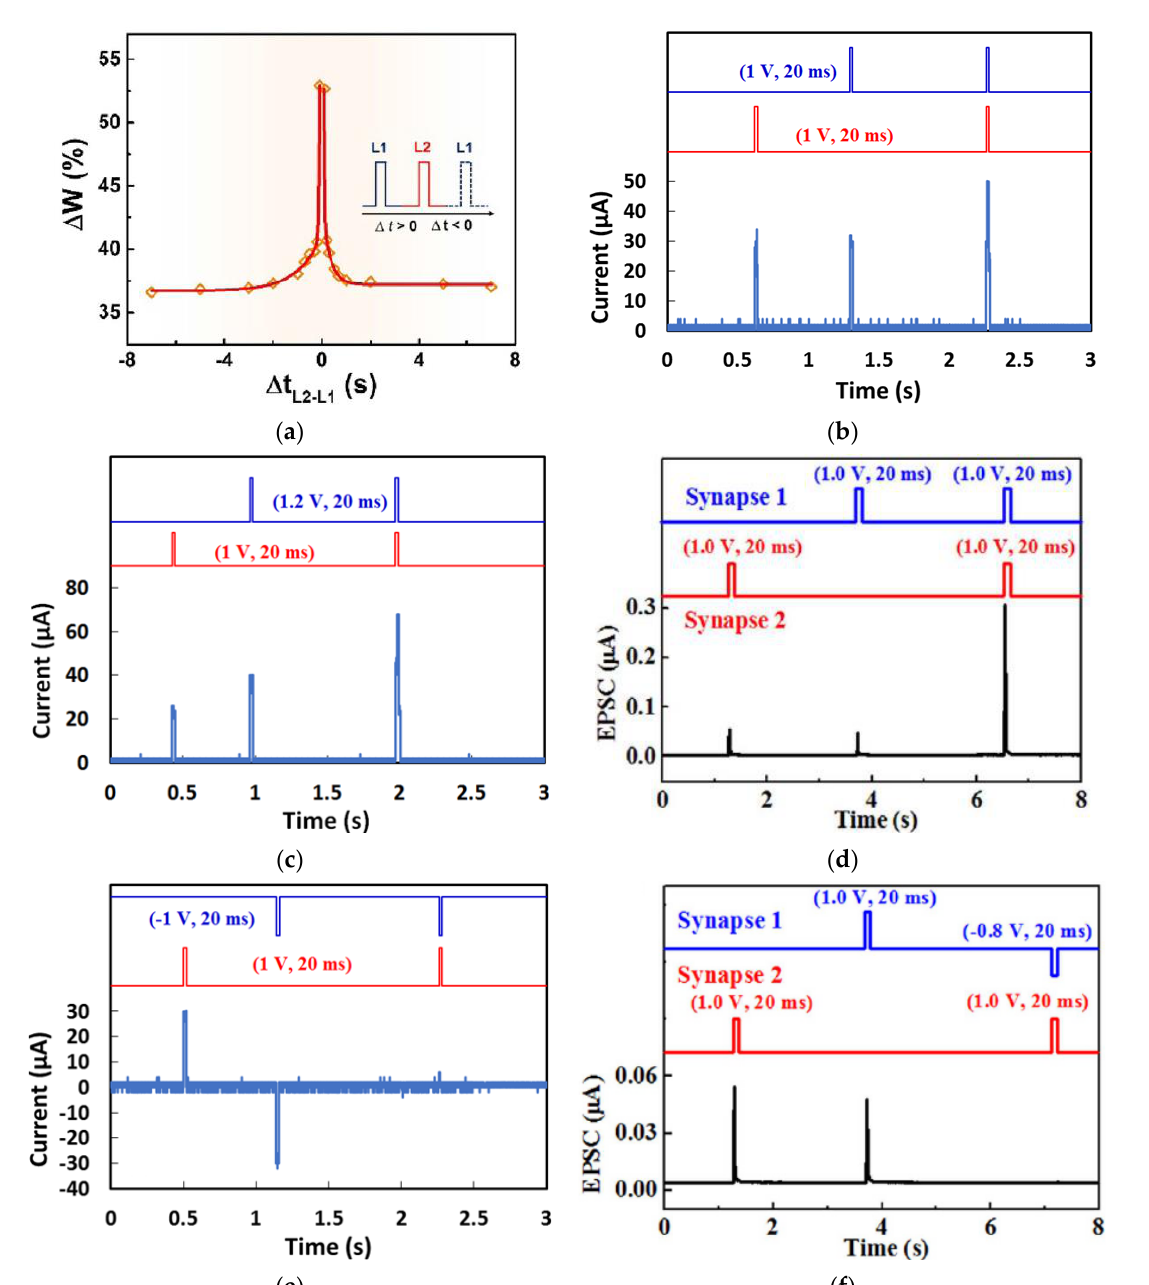
Figure 12. Synaptic spatial summation reported by natural organic transistors and memristors. ( a ) Chlorophyll-a-based synaptic transistor with optical input stimuli [60]. ( b ) Sublinear spatial summation and ( c ) linear spatial summation by honey-memristors [17]. ( d ) Supralinear spatial summation by chicken albumen-gated synaptic transistors [43]. ( e , f ) Shunting inhibition by honey-memristors [17] and chicken albumen-gated synaptic transistors [43].